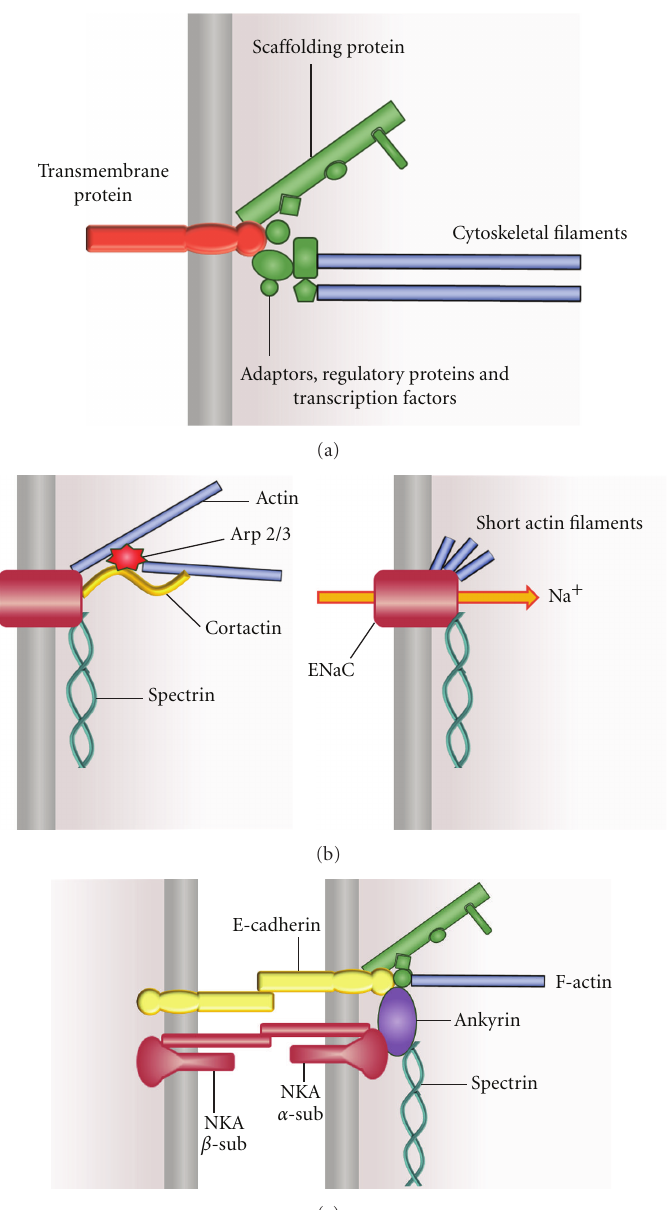
Figure 2: (a) General schematic representation of an anchoring junction. The scheme depicts the basic organization of the proteins comprising an anchoring junction. The three organizational levels (see text) are represented by di ff erent colors; modified from Matter and Balda [34]. (b) Scheme representing some of the interactions between ENaC and the cytoskeleton. The channel is kept in its membrane location via the spectrin-based cytoskeleton. In the nonstimulated state, ENaC is bound to F-actin directly and/or by cortactin-Arp2/3 interaction (left panel). Diverse stimuli promote formation of short actin filaments that activate ENaC by direct binding to the channel (right panel). See main text for references. (c) Scheme representing some of the interactions between the Na + -K + ATPase (NKA) and the cytoskeleton; modified from Bennett and Healy